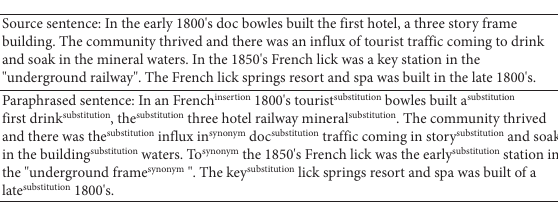
Figure 2: The samples of paraphrase sentence pair: different words, the similar syntactic structure, and the same